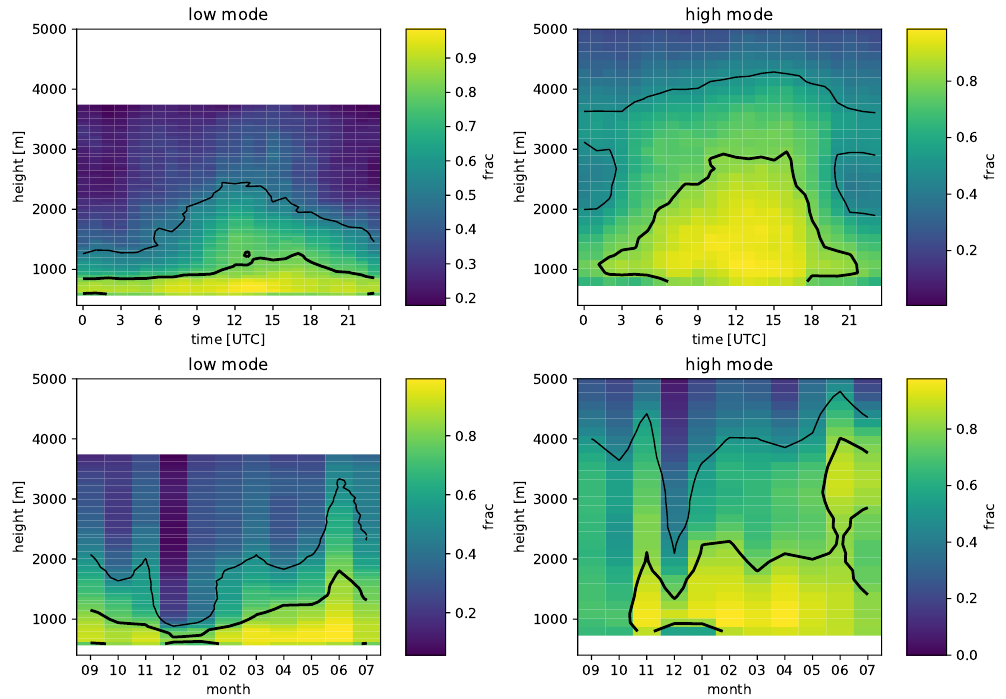
Figure 2. Availability of wind profiler data by time of day ( upper row ) and by month ( lower row ) as a function of height (m MSL) for the low-mode ( left ) and high-mode ( right ). Bold contour lines denote the fraction equal to 80%, and thin contour lines denote